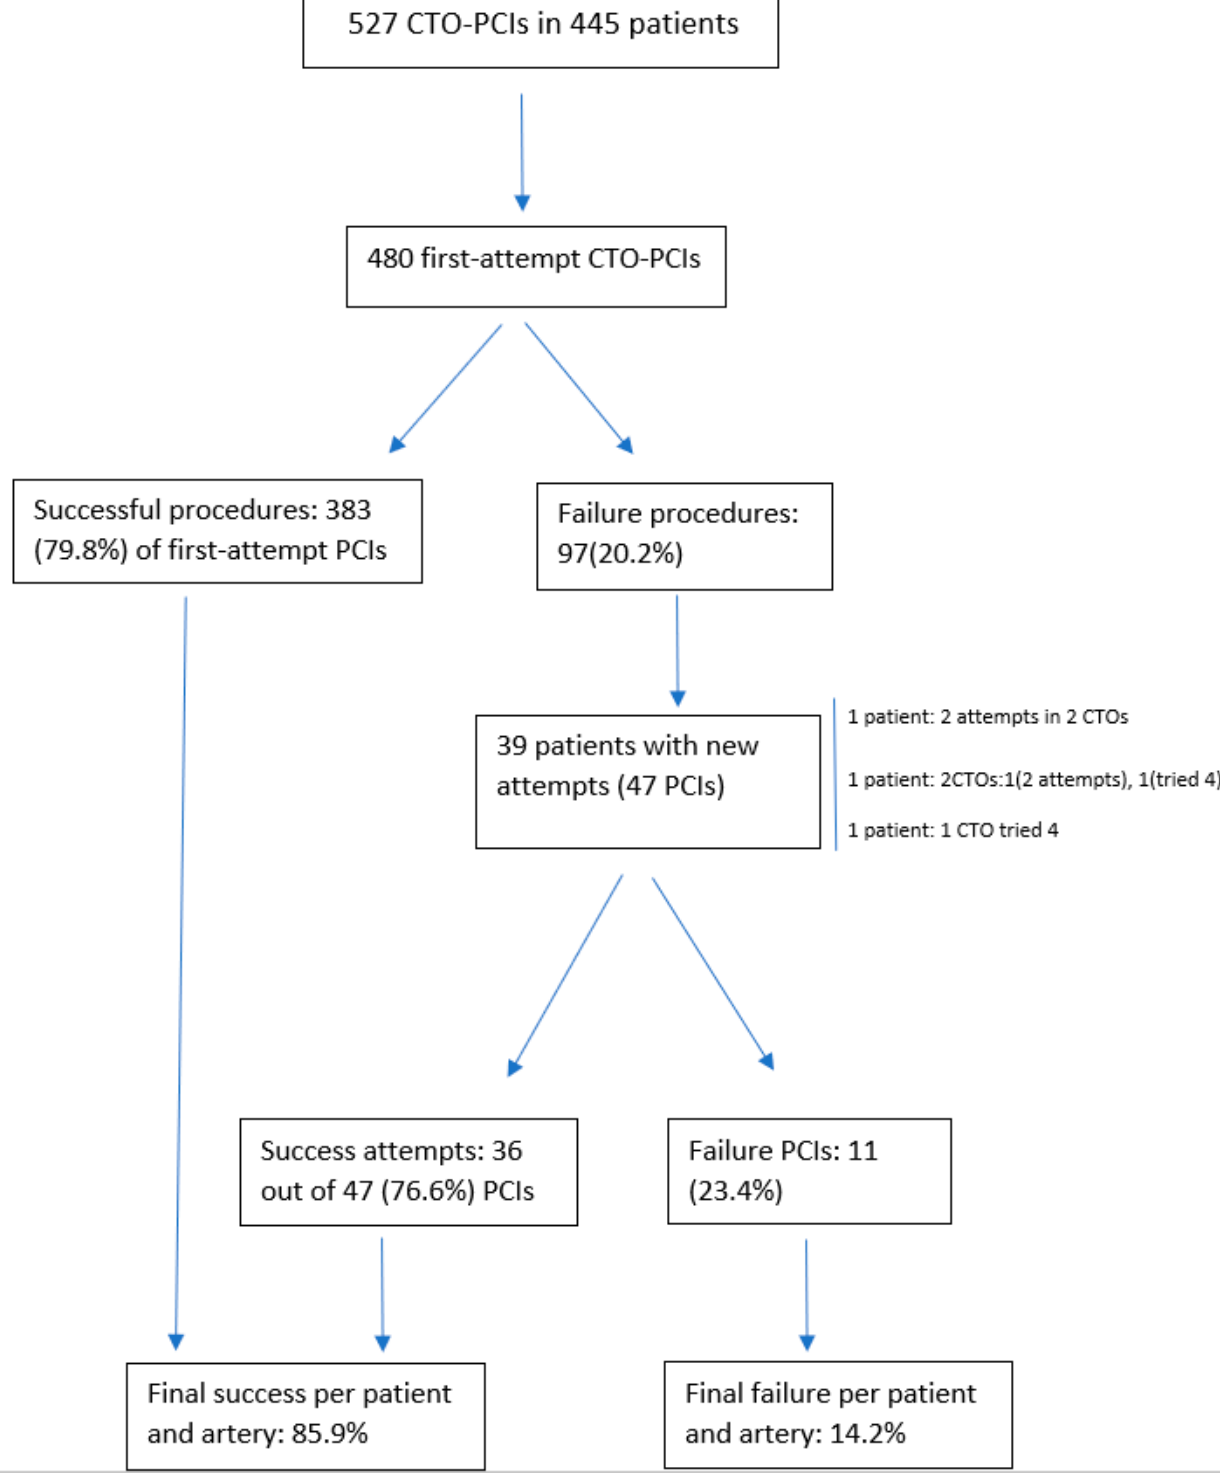
Figure 1. Flowchart of the entire cohort including new attempts. Table 1. Basal and demographic characteristics comparison of first-attempt and reattempted CTO- PCI in the study population .